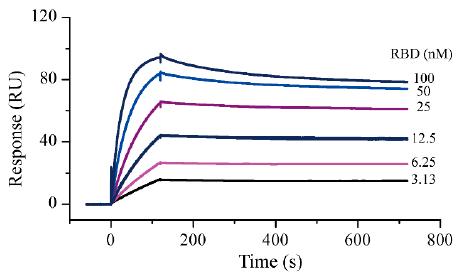
Figure 1. Surface plasmon resonance sensorgrams for S-RBD-mFc interaction with captured ACE2- His. Increasing concentrations of S-RBD were injected over the surface. Contact time and dissociation time was kept at 120 and 500 s, respectively. Data were analyzed with Biacore S200 evaluation software (v 1.0) and automatically fitted to the 1:1 binding model.